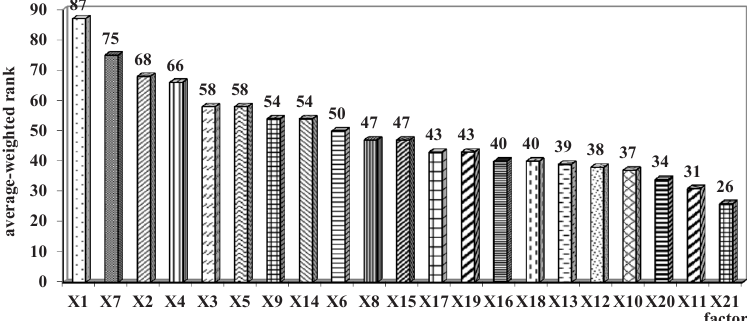
Fig. 1. Distribution histogram in terms of the significance of the factors affecting the magnitude of the logistics costs of the PIS: X1 – the scope of the PIS; X2 is the degree of complexity of the assortment structure of the PIS and the structure of the use of materials; X3 – production structure of PIS; X4 – the value of inventories of material resources (MR); Х5 – level of novelty and equipment status; X6 – level of novelty of technologies; Х7 – qualification of the personnel; Х8 – organization of processes of physical movement of materials at the enterprise, etc.); Х9 – level of prices for logistic services provided by third parties; Х10 – rate of crediting of capital attracted for financing of logistic activity; X11 – competitors; X12 – suppliers; Х13 – quantity of deliveries of